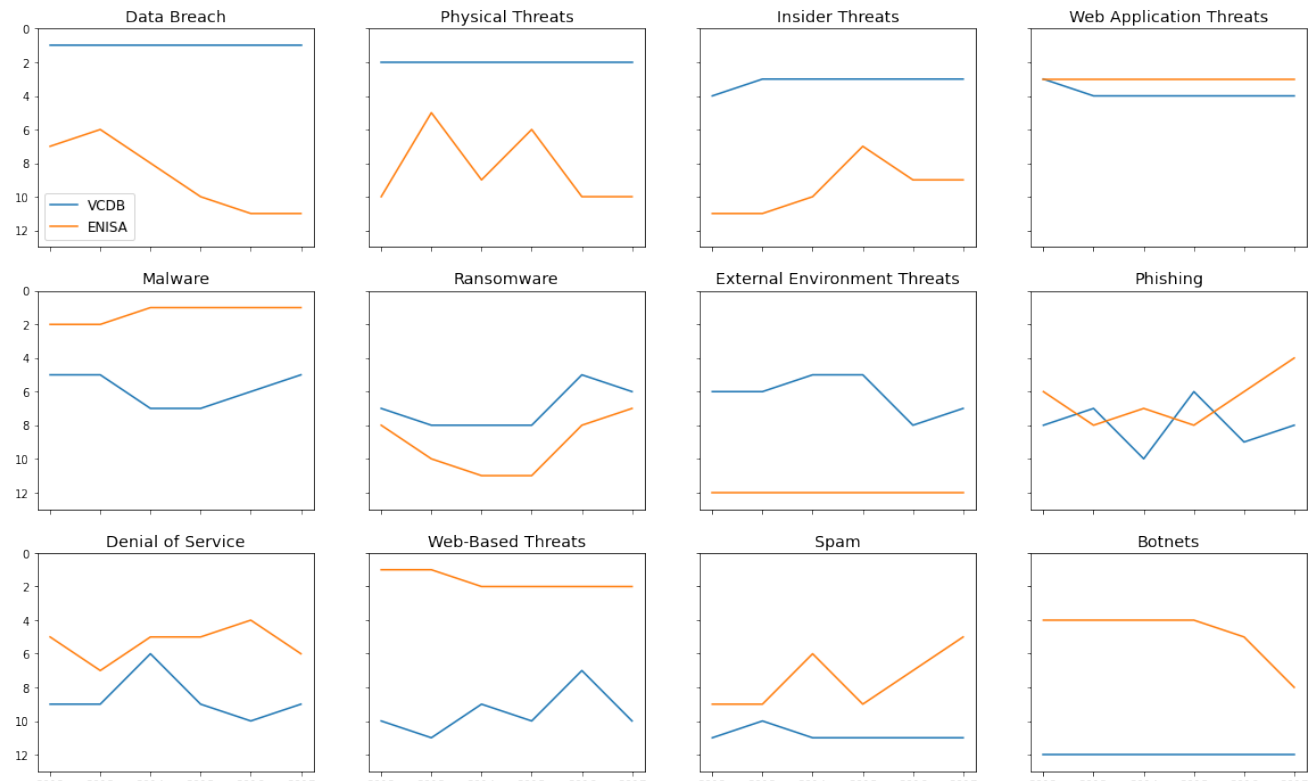
Figure 1. VCDB and ENISA threat rankings compared over time. For several threats we observe large ranking